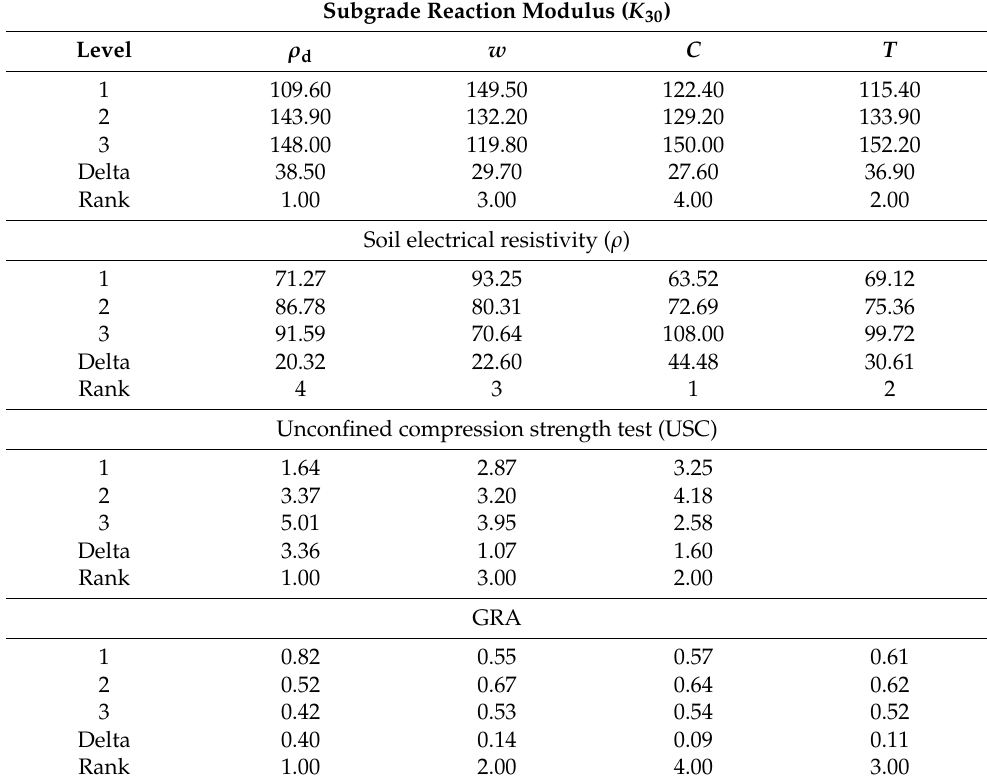
Table 3. Response table for mean.